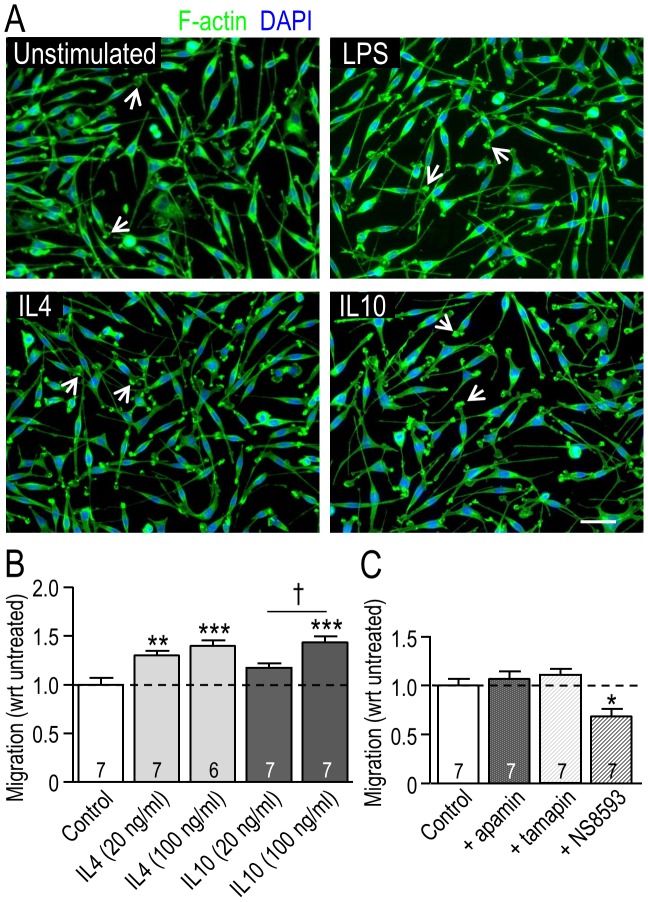
Migration of MLS-9 microglial cells is increased by IL4 and IL10, and involves TRPM7, not KCa2.3.
A. Representative fluorescence micrographs show MLS-9 cells (rat microglial cell line), unstimulated or 24 hr after stimulation with LPS (100 ng/ml), IL4 (20 ng/ml) or IL10 (20 ng/ml). Cells were stained for F-actin with phalloidin (green) and the nuclear marker, DAPI (blue). Most cells were bipolar with membrane ruffling at one end (examples shown by arrows). Scale bar, 50 µm. B. MLS-9 microglial cells in the upper well of Transwells were unstimulated, or stimulated (24 hr) with 20 or 100 ng/ml IL4, or with 20 or 100 ng/ml IL10. The number of cells that migrated to the underside of the filter was then counted and normalized to control (unstimulated) cells. The dashed line in both graphs indicates the level in control (unstimulated) cells. C. Cells were stimulated as in panel B, with or without a channel inhibitor: 100 nM apamin, 5 nM tamapin, or 7 µM NS8593. For each stimulus, the number of cells that had migrated was normalized to the level without a channel inhibitor. Data are expressed as mean ± SEM with the number of individual cultures indicated on each bar. In panel B, a two-way ANOVA with Bonferroni post-hoc analysis was used to determine significant differences between stimulation (*) and dose (†). In panel C, A one-way ANOVA with Tukey's post-hoc test was used to determine treatment effects. One symbol, p<0.05; two symbols, p<0.01; three symbols, p<0.001.